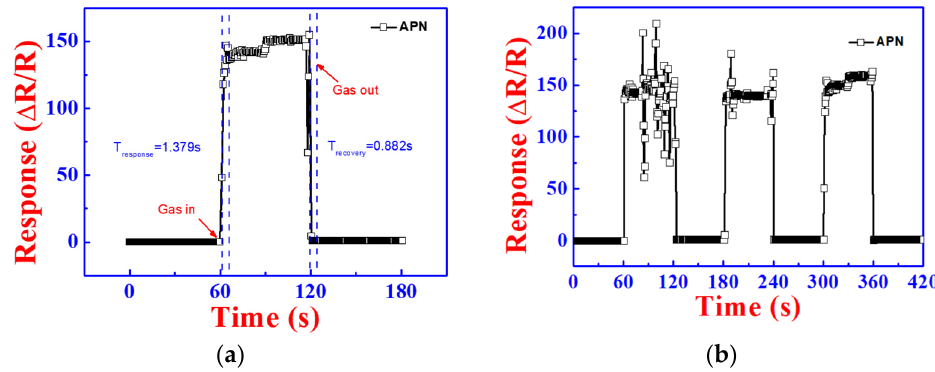
Figure 8. ( a ) Response and recovery time, and ( b ) dynamic repeatability of the APN sensor at 10 ppm ethanol, 250 °C.